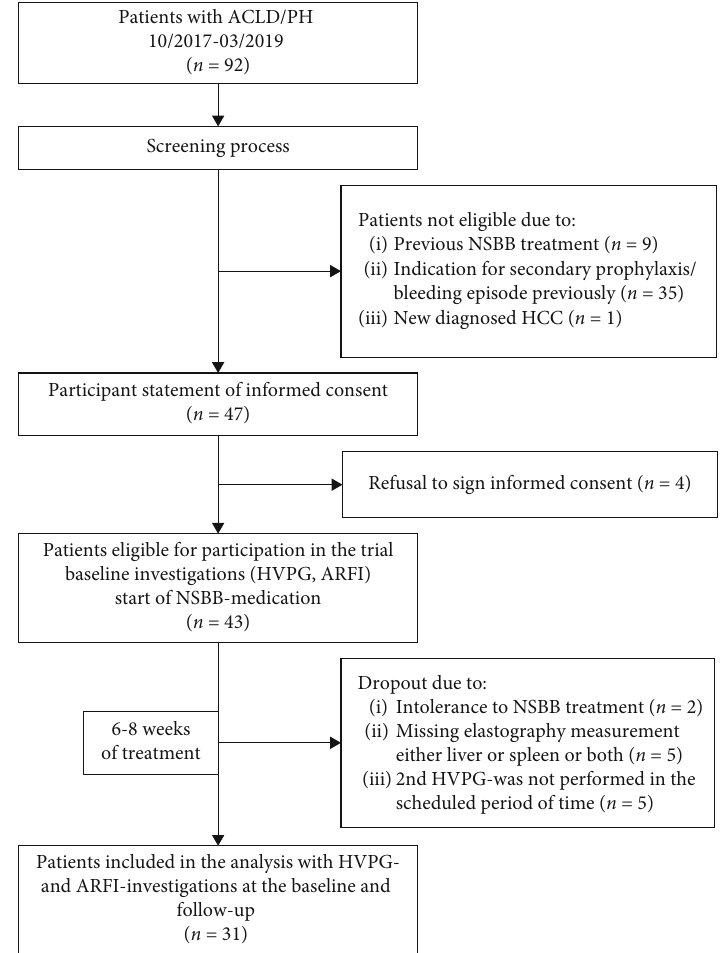
Figure 1: Flowchart for the study enrollment process (NSBB =non-selective beta-blocker; HCC=hepatocellular carcinoma; HVPG=hepatic venous pressure gradient; ARFI=acoustic radiation force